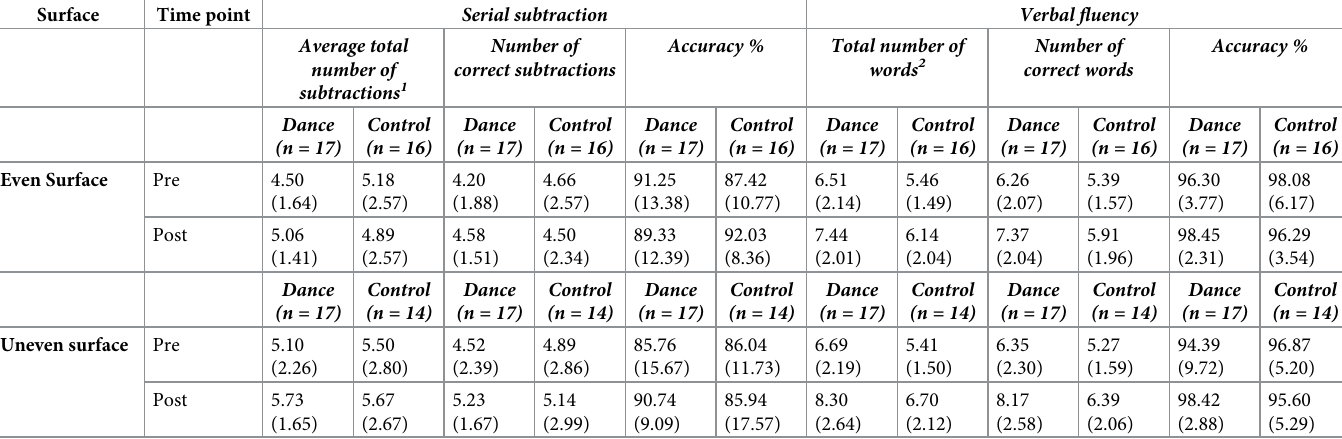
Table 2. Accuracy of the verbal fluency and serial subtraction